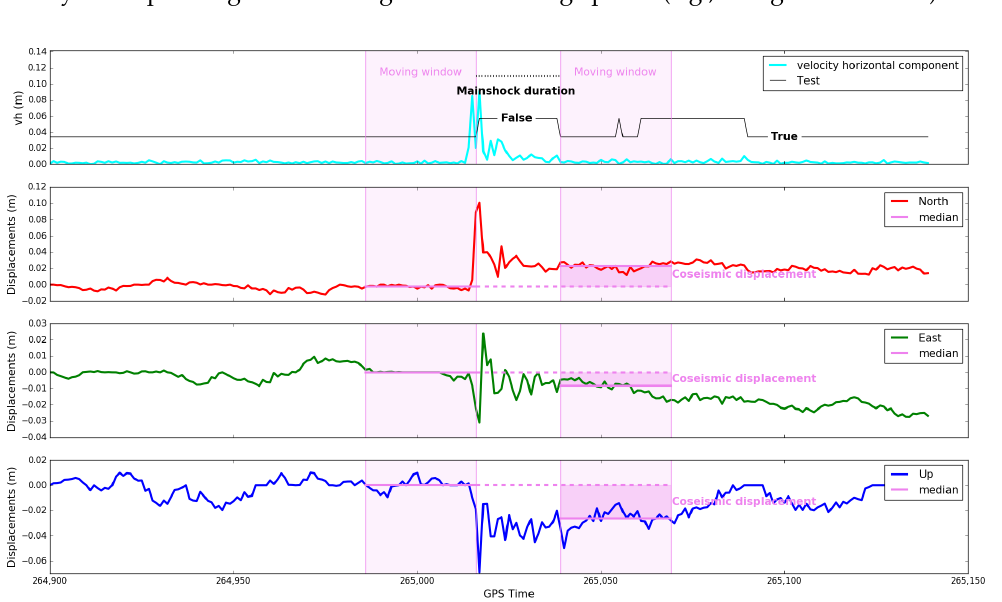
Figure 9. VADASE real-time coseismic displacement estimation at AMAT (Amatrice) for the 24 August 2016 main shock.